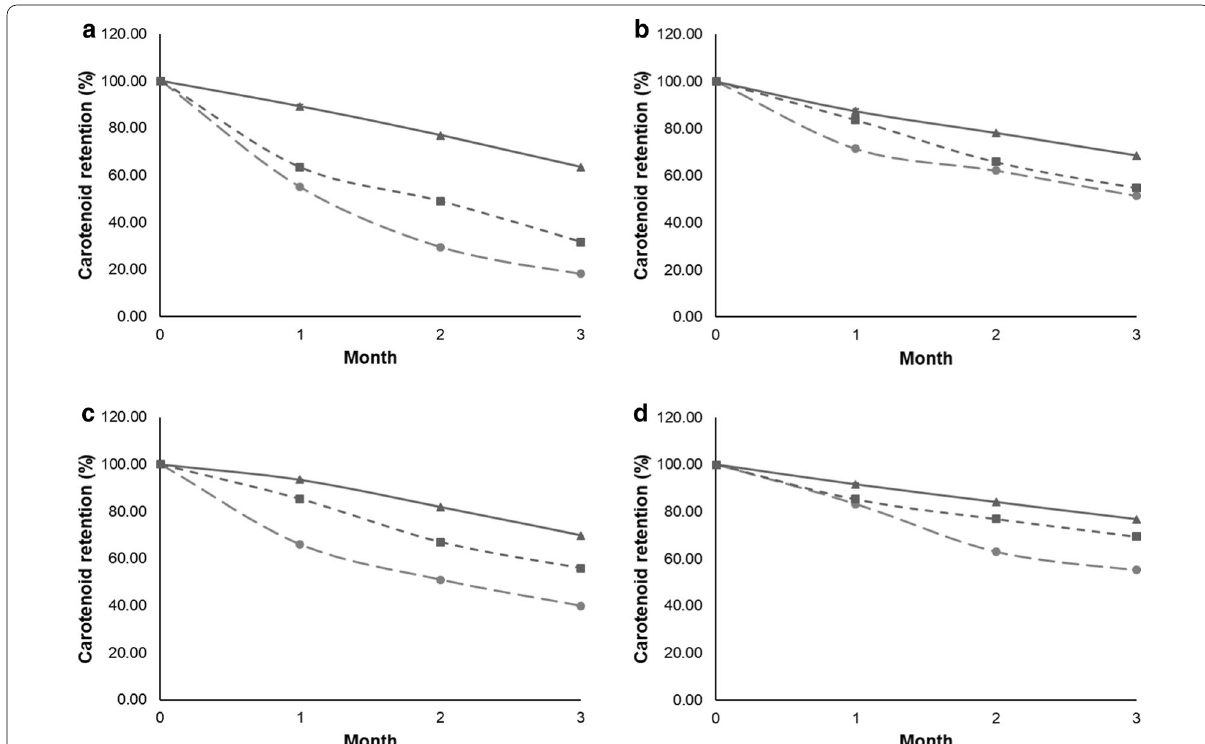
Fig. 3 Carotenoid contents of mamey and carrot microcapsules stored at different temperature and light conditions. “Filled triangle” (4 °C without access to daylight); ““Filled rectangle” (25 °C without access to daylight); ““Filled circle” (25 °C in daylight). a M AG 5; b M AG 10; c C AG 5; d C AG 10. The data shown correspond to means SDs ( n ± =